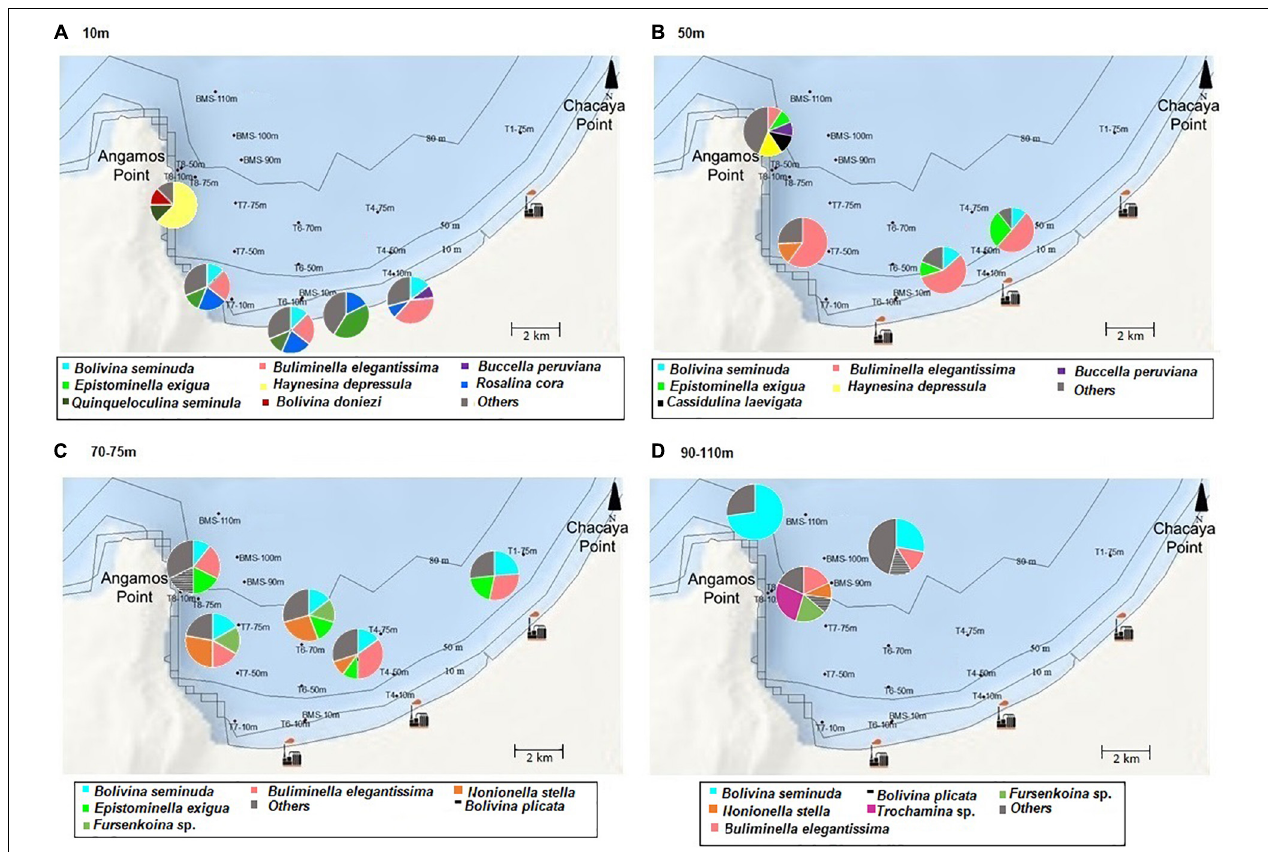
FIGURE 6 | Abundances (%) of the most representative benthic foraminifera according to depth. (A) 10 m, (B) 50 m, (C) 70–75 m, (D) 90–110 m (spatial